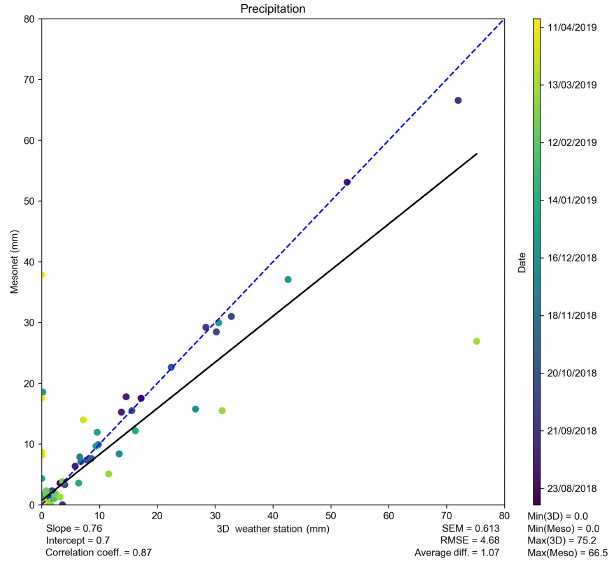
Figure 12. Comparison of the daily precipitation accumulation for the 3D-printed tipping bucket rain gauge using a Hall effect sen- sor ( x ) and the Oklahoma Mesonet ( y ) for the entire deployment, color-coded by time. The one-to-one reference line (blue dashed) and linear regression line (black solid) are